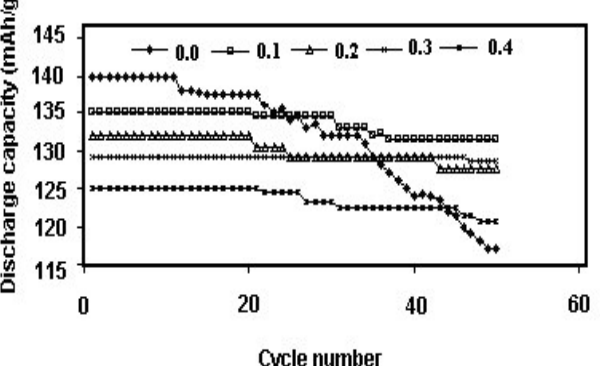
Figure 8. Plots of specific capacity vs. cycle no. of LiMn 2 O 4 and LiNd x Mn 2-x O 4 (x = 0.1, 0.2, 0.3 and